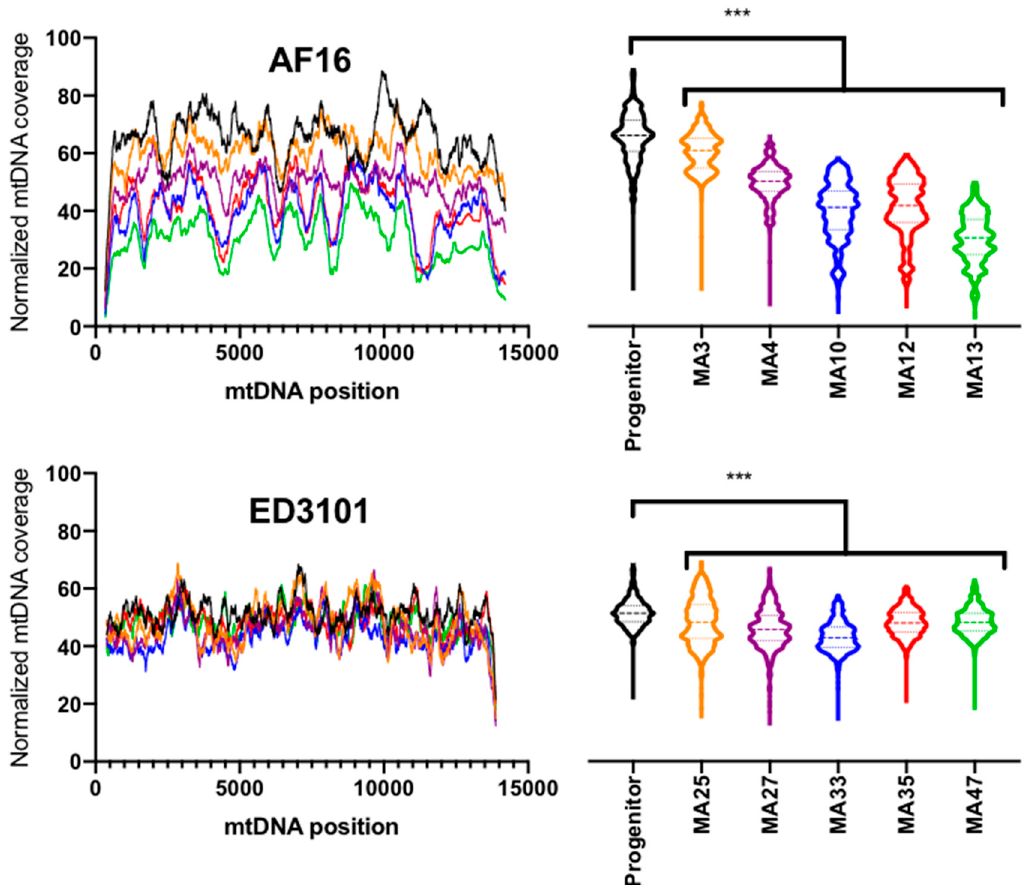
Figure 5. Relative mtDNA coverage in AF16 and ED3101 C. briggsae MA lines. MtDNA content is reduced relative to progenitors in AF16 (top panels) and ED3101 (bottom panels) lines following MA. The AT-rich region of the mitochondrial genomes was omitted from analysis. Colors for the mtDNA position coverage plots (left panels) correspond to their respective progenitor and MA line colors for the violin plots (right panels). MA lines were compared to progenitor lines using Kruskal–Wallis test followed by Dunn’s multiple comparisons test (***, p < 0.001).